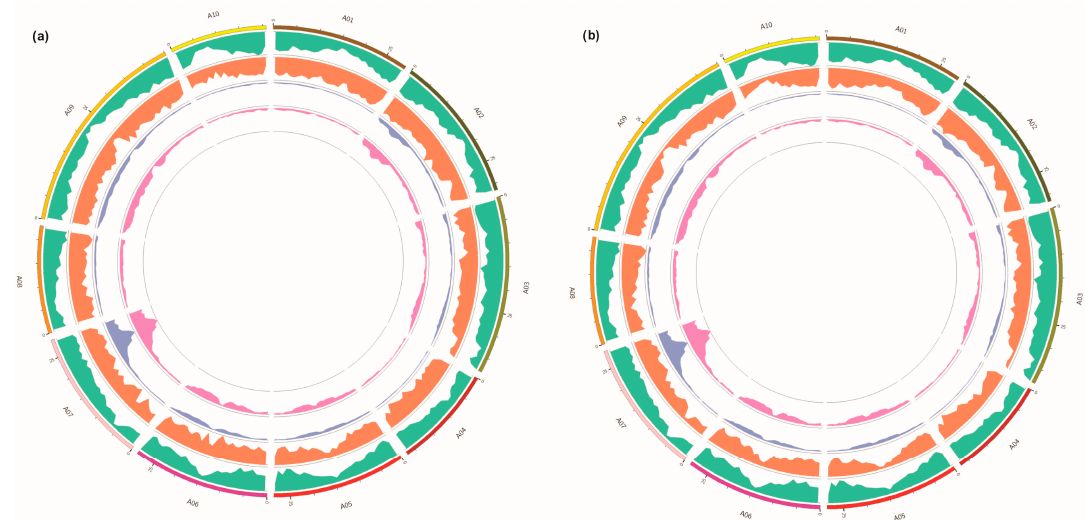
Figure 2. Visualization the distribution of SNPs ( a ) and InDels ( b ) between samples on the chromo- somes. From the outside to the inside: the first circle, chromosome coordinates; the second circle, gene distribution; the third circle, InDel density distribution; the fourth circle, ED value distribution; the fifth circle, ∆ InDel-index value distribution.